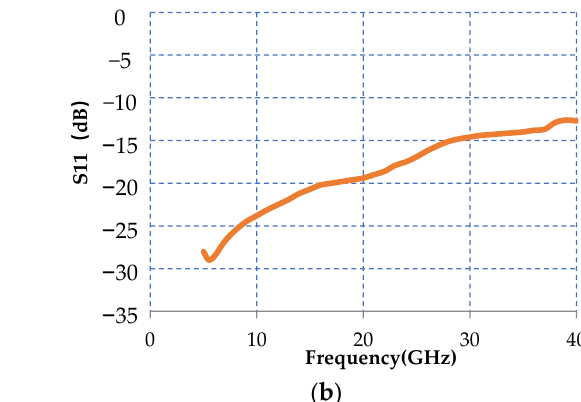
Figure 7. Improving design for gold-ribbon wrap bonding. Figure 8. The photo and test results of the gold-ribbon wrap bonding with improvement. ( a ) Photo of the wrap bonding with improvement; ( b ) Reflection loss of the wrap bonding with improve- ment.